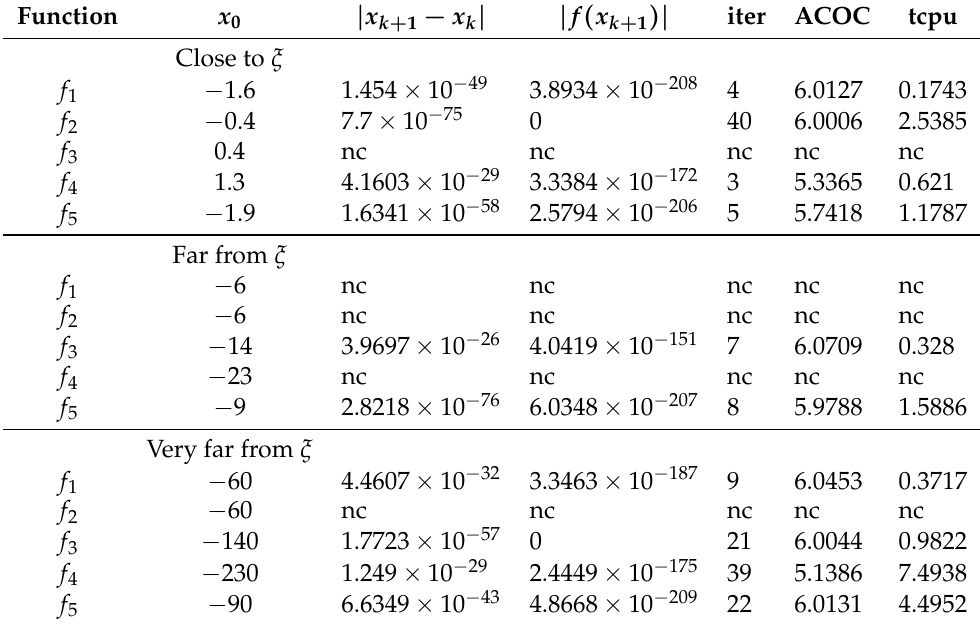
Table 7. Numerical performance of CMT ( − 300) method in nonlinear